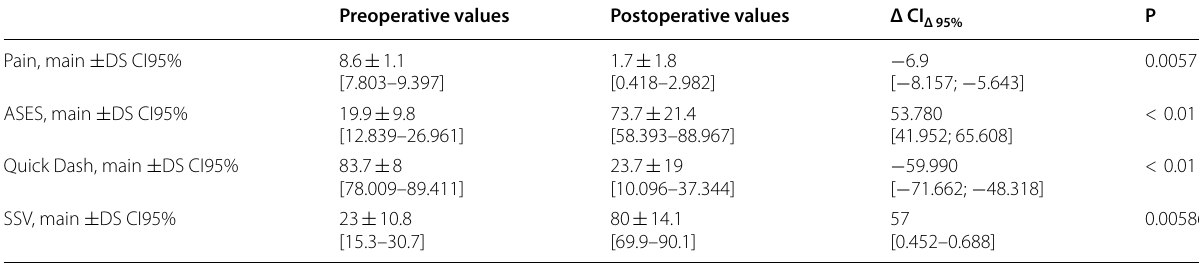
Table 2 Comparison between preoperative and postoperative variables Preoperative